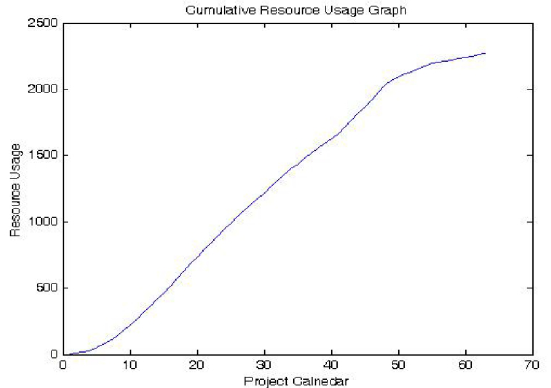
Figure 38. Cumulative resource usage for resource 1 of experiment 3 (relaxed resource constraint)